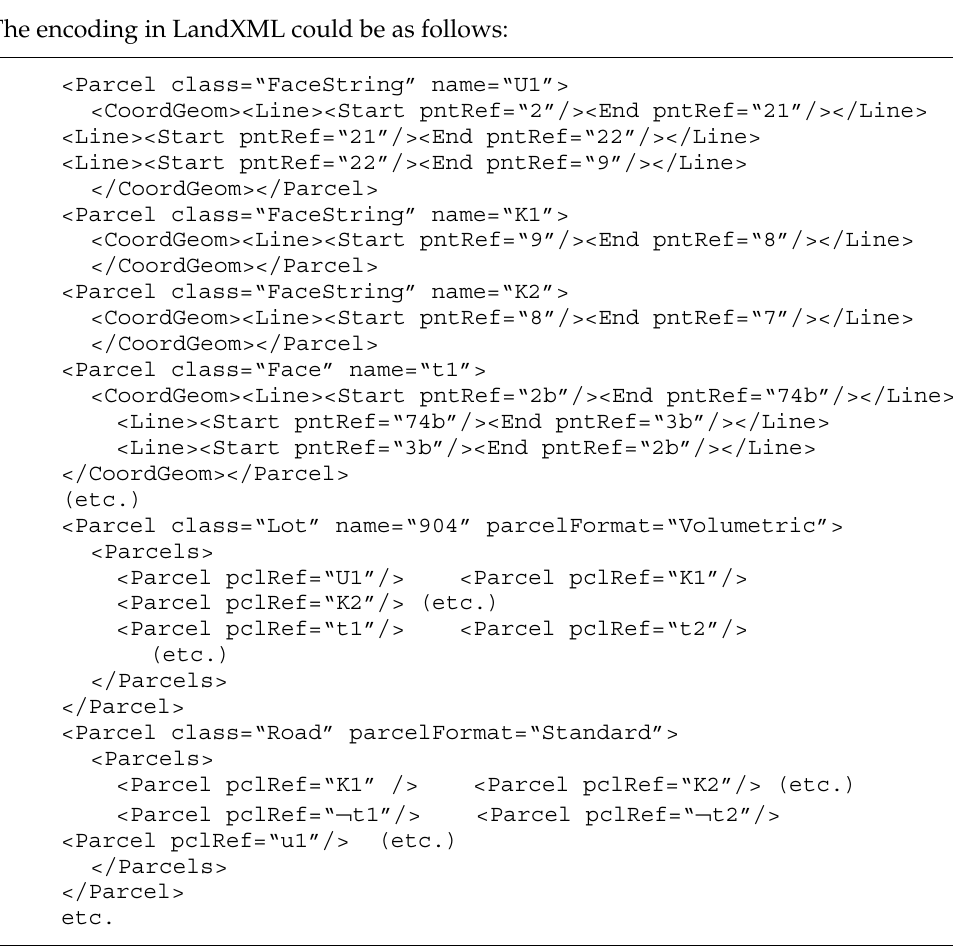
Figure 7. Figure 3, with the addition of the surface road parcel.